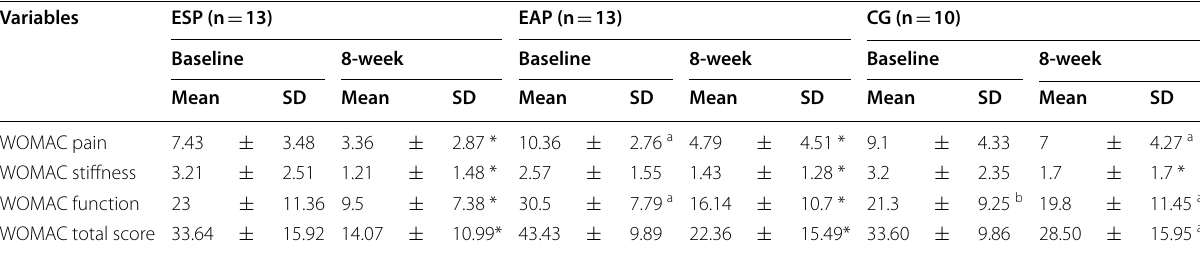
Table 2 Means and SD of Western Ontario and McMaster Universities Osteoarthritis Questionnaire